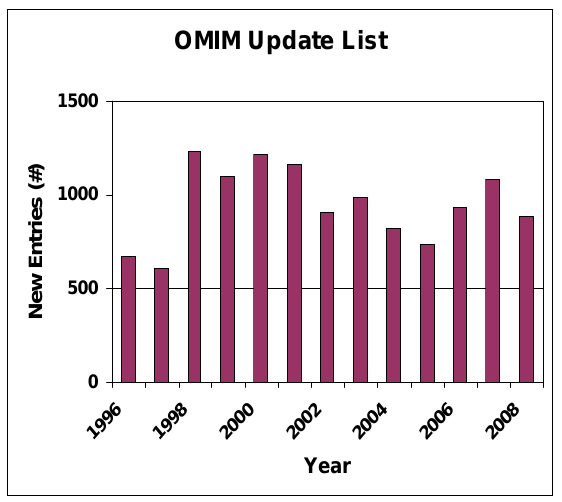
Figure 6. OMIM Update List